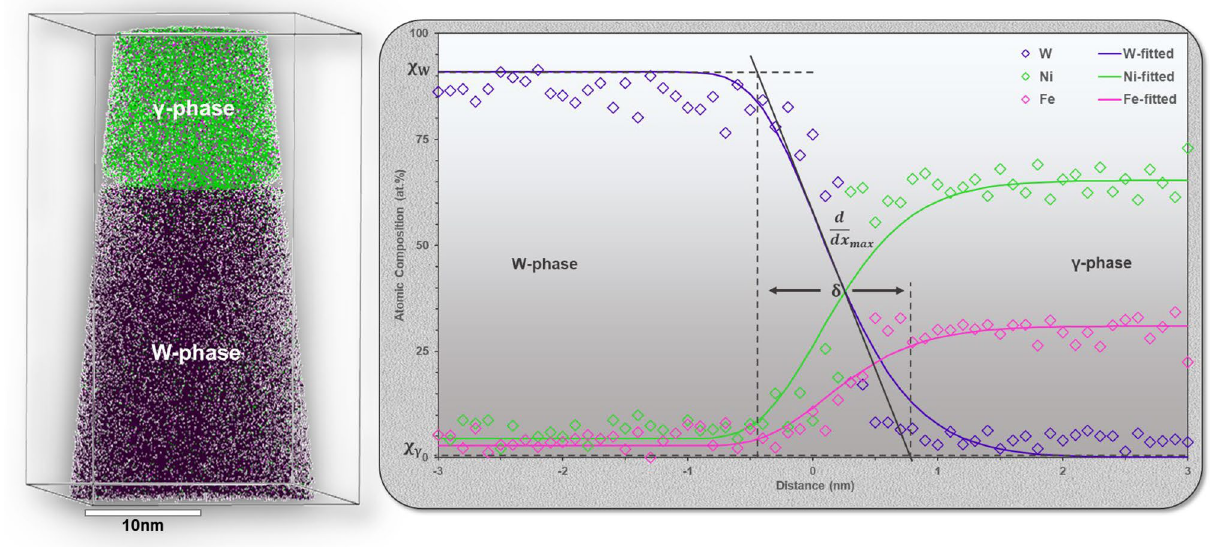
Figure 6. (Left) APT reconstruction of IPB region showing W in purple, Ni in green, and Fe in pink. (right) Compositional profile across a region of the reconstructed APT tip. This data was fitted in the same method as Fig. 5. Profile proceeds from the W-phase on the left to the γ-phase on the right with the δ-value determined from the fitted curve for the W-phase. The acquired compositions and IPB width values for Ni and Fe